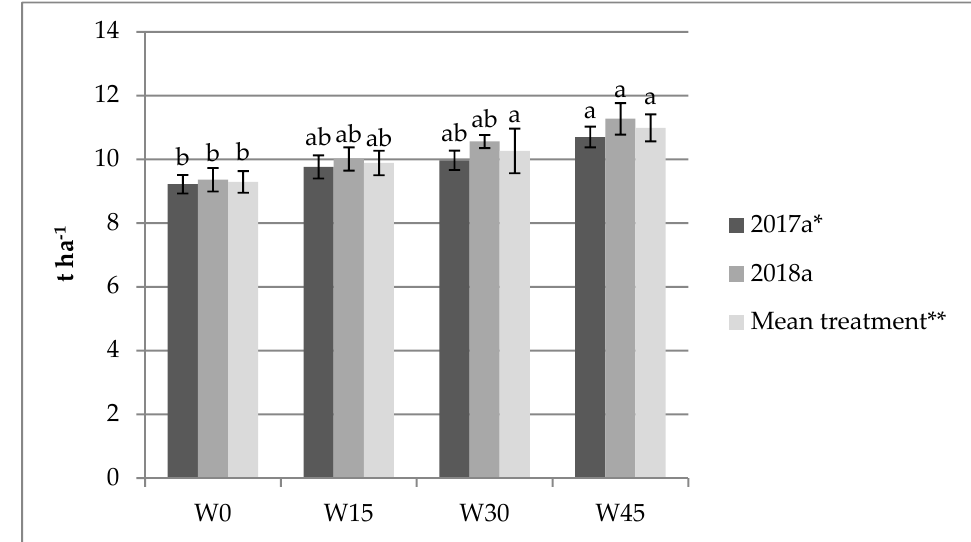
Figure 8. Maize grain yield. W0—the control with no stillage treatment, W15—15 m 3 of stillage per hectare, W30—30 m 3 of stillage per hectare, W45—45 m 3 of stillage per hectare. * means of years regardless of treatments; ** means of treatments regardless of years. The same letter means not significantly di ff